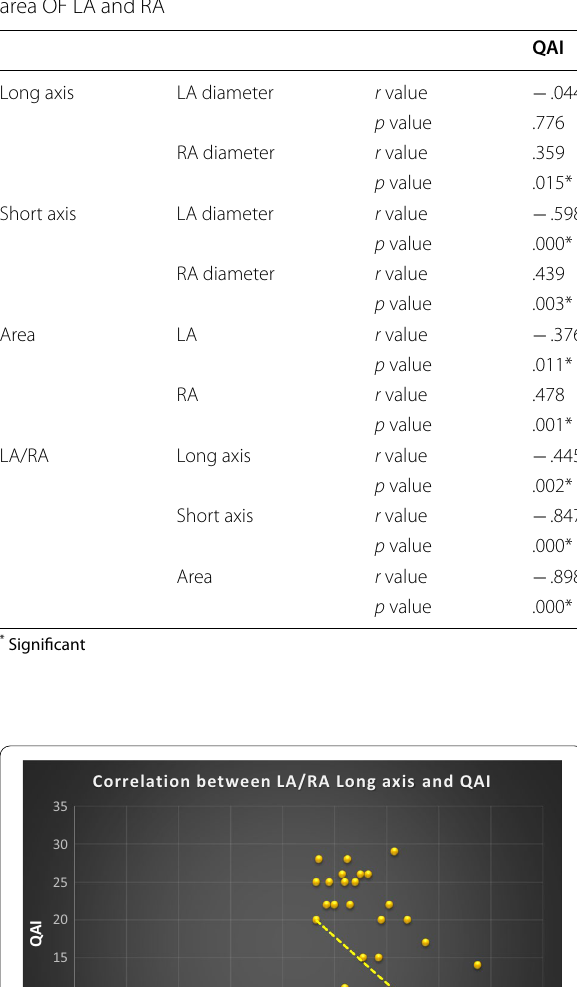
Table 4 Range of LA/RA area and corresponding PAOI in our